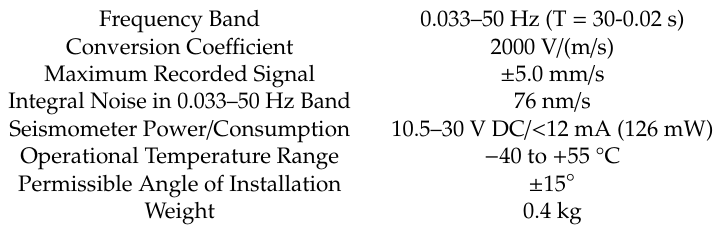
Table 2. Parameters of molecular–electronic seismic sensor